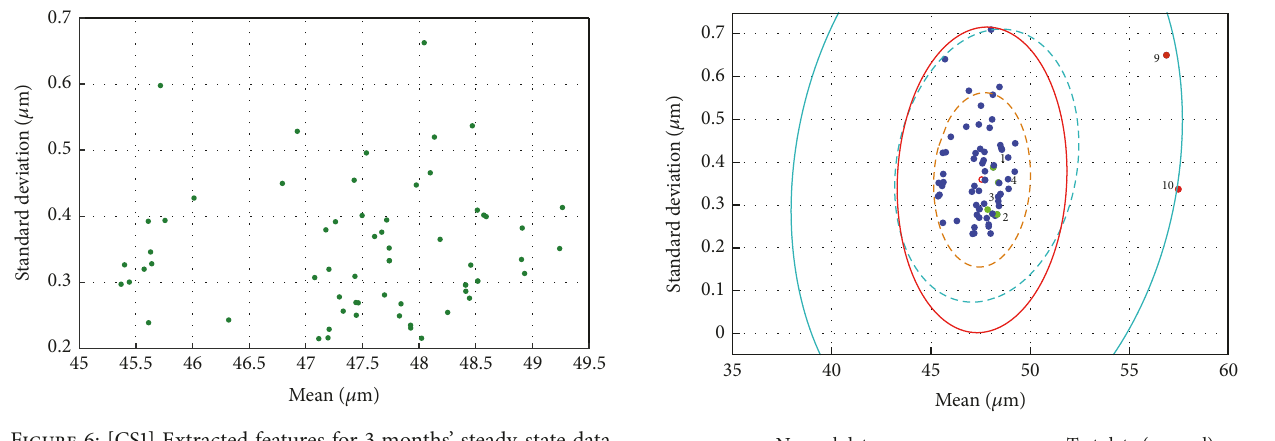
Figure 6: [CS1] Extracted features for 3 months’ steady-state data (months 1–3—normal operation).